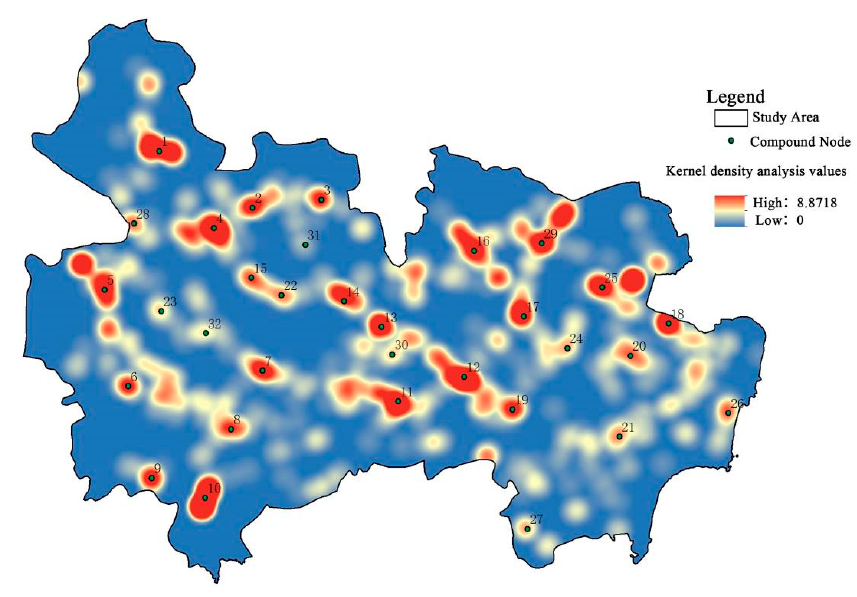
Figure 4. The kernel density analysis results—spatial distribution of the ecological nodes.